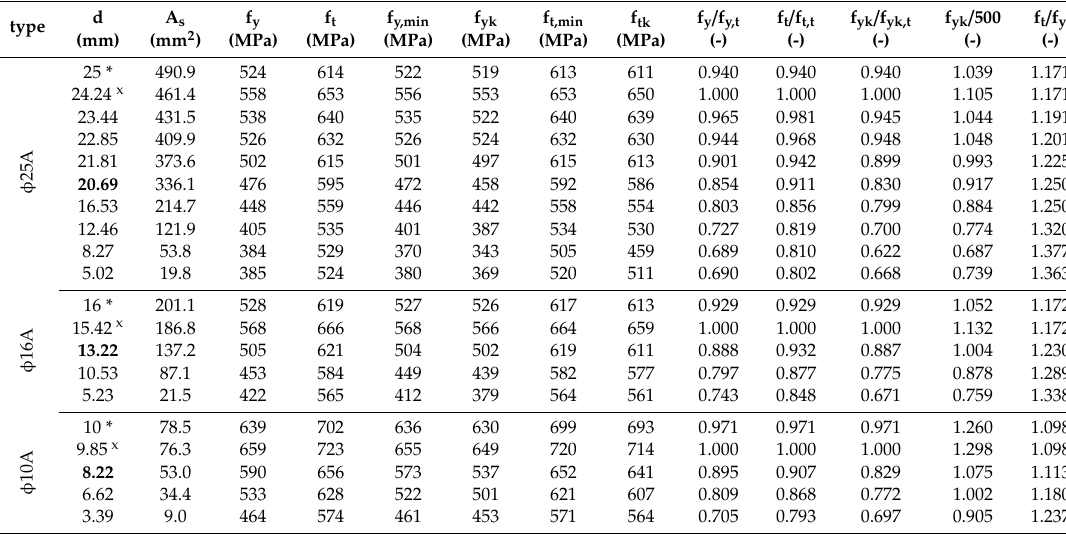
Table 2. Mechanical properties of tensile tests.